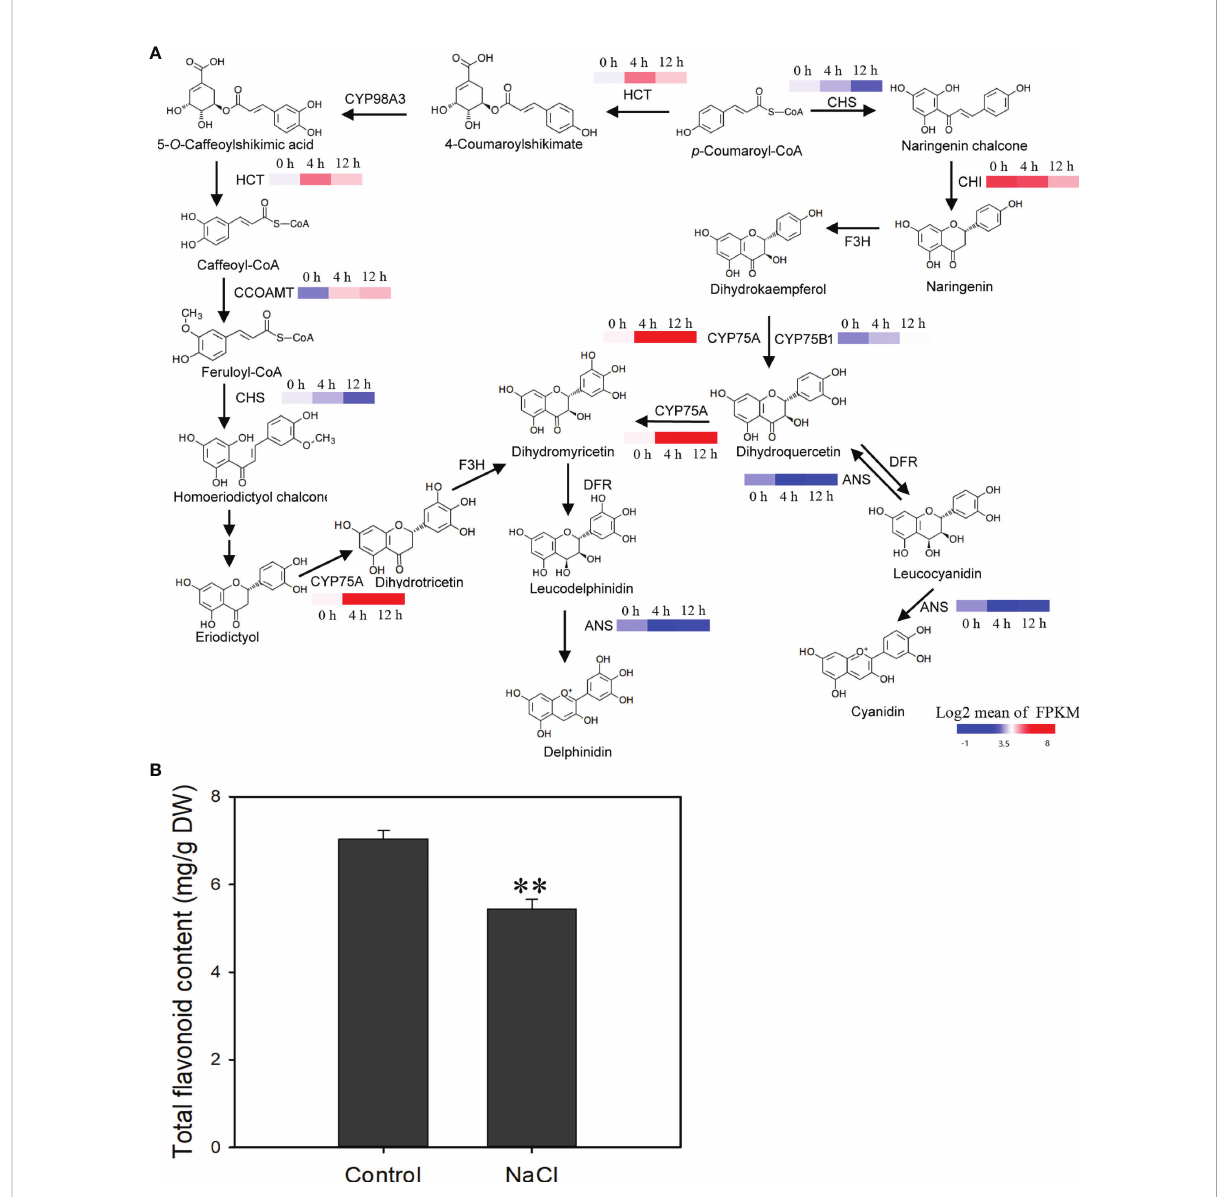
FIGURE 9 Changes in the expression of fl avonoid biosynthetic genes and reduction of total fl avonoids in response to salt treatment. (A) NaCl ‐ stress induced changes in the expression of fl avonoid biosynthetic genes. CHS, chalcone synthase; HCT, shikimate O -hydroxycinnamoyltransferase; CYP98A, 5-O-(4-coumaroyl)-D-quinate 3 ’ -monooxygenase; CCOAMT, caffeoyl-CoA O -methyltransferase; CHI, chalcone isomerase; F3H, naringenin 3-dioxygenase; CYP75A, fl avonoid 3 ’ ,5 ’ -hydroxylase; DFR, dihydro fl avonol 4-reductase; ANS, anthocyanidin synthase. (B) Estimation of total fl avonoid content after salt stress. The roots of plantlets were collected after 250 mM NaCl treatment for two weeks and used to measure total fl avonoid content. Bars indicate means ± standard deviation of three replicates. ** indicates signi fi cant differences at P < 0.01 according to the Dunnett test. DW, dry weight. Genes that changed signi fi cantly in at least one time point after salt treatment are